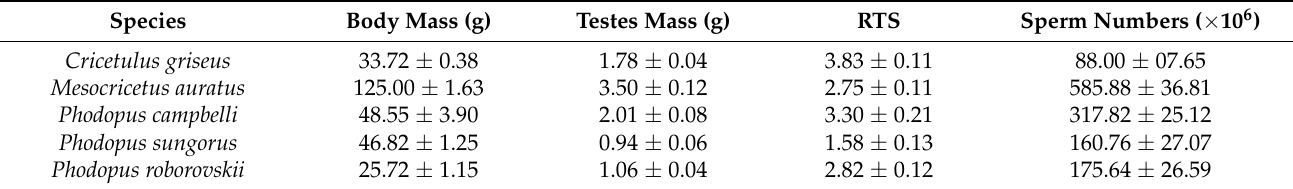
Table 2. Corporal measurements and sperm numbers in five hamster species. Values indicate mean ± standard error. RTS: relative testes size calculated according to Kenagy and Trombulak [75]. Species Body Mass (g)